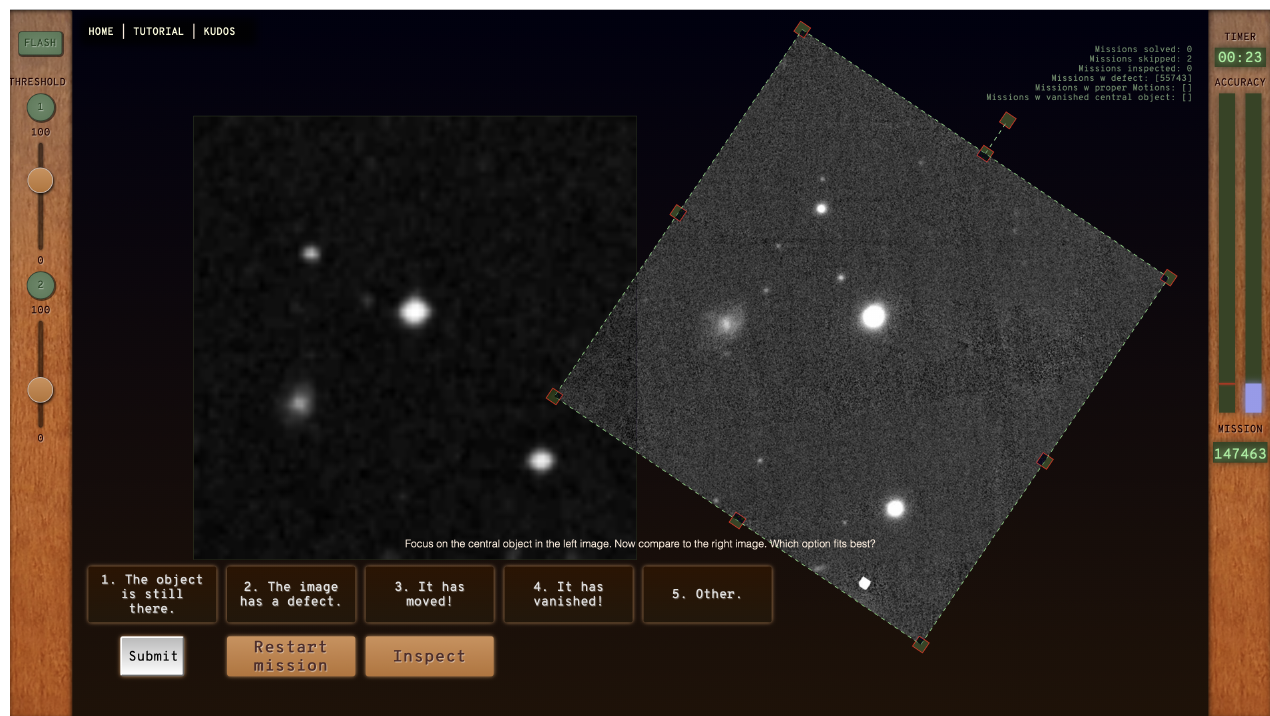
Figure 3. The splashscreen from the citizen science project’s webpage.